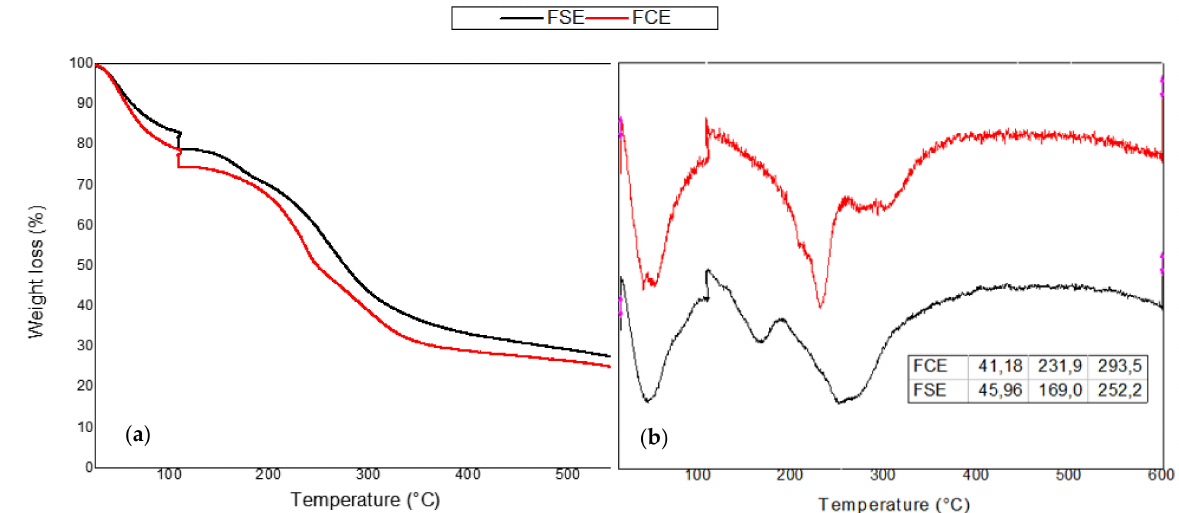
Figure 5. ( a ) Mass loss (%) and ( b ) thermogravimetric analysis (TGA) curve for FCE and